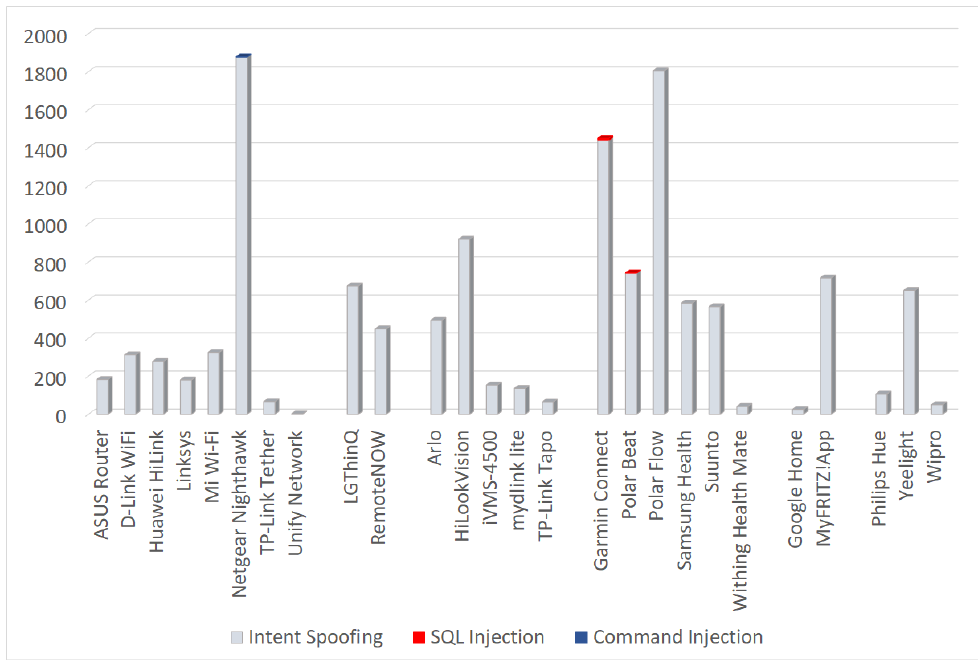
Figure 6. Issues identified through taint analysis. The Y axis designates the amount of issues per